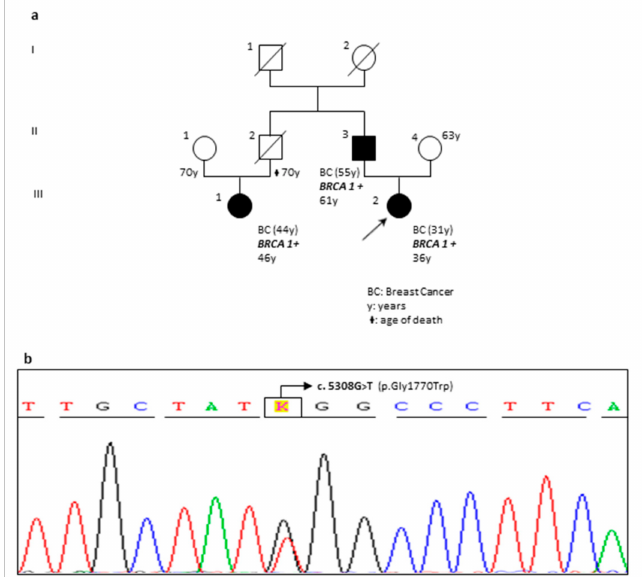
Figure 6. Pedigree and sequencing result of the patient carrying the novel BRCA1 c.5308G > T; p.(Gly1770Trp) variant. ( a ) Pedigree of the proband’s family with three generations depicted. Proband is indicated with an arrow. Black circles and squares indicate a ff ected individuals. Cancer type and age at diagnosis are reported and described as: BC, breast cancer. The current age and age of death are also reported. Family members carrying the pathogenic variant are marked with BRCA1 + . ( b ) Electropherogram showing the BRCA1 c.5308G > T variant causing the p.(Gly1770Trp) aminoacidic substitution within exon